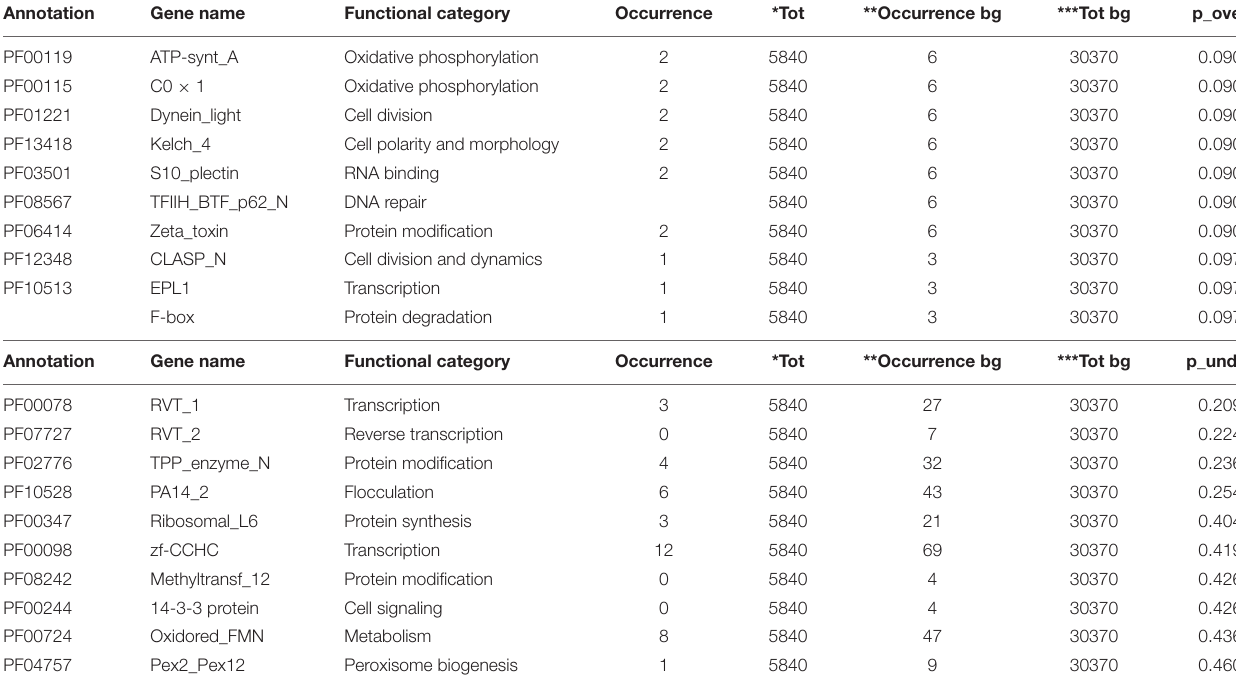
TABLE 7 | The top 10 enriched and under-represented domains of H20